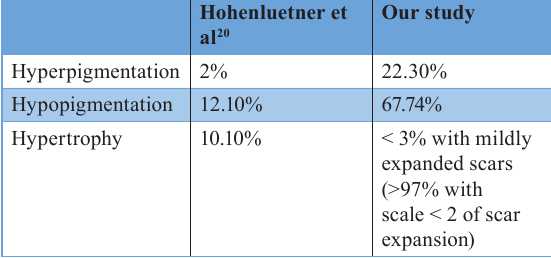
over observer overall opinion indicates us to provide better